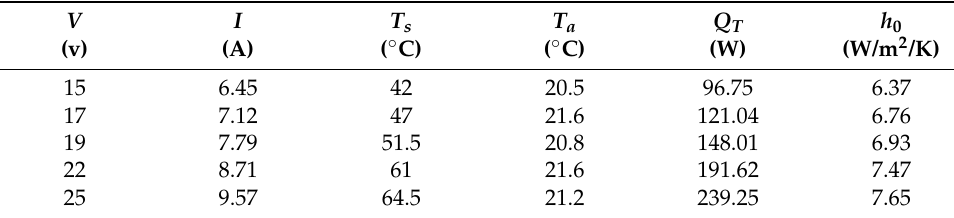
Table 5. Experimental